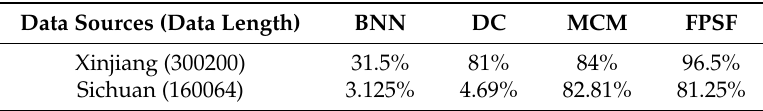
Table 2. Accuracy